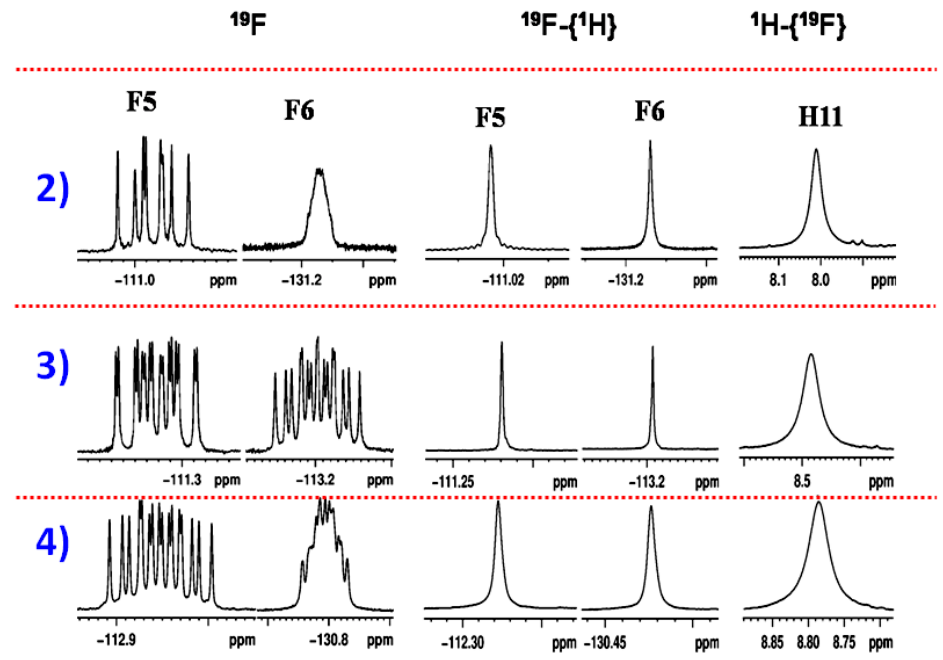
Figure 4. The 400 MHz 19 F, 19 F-{ 1 H} and 1 H-{ 19 F} NMR spectra of molecules 2 , 3 and 4 in CDCl 3 .